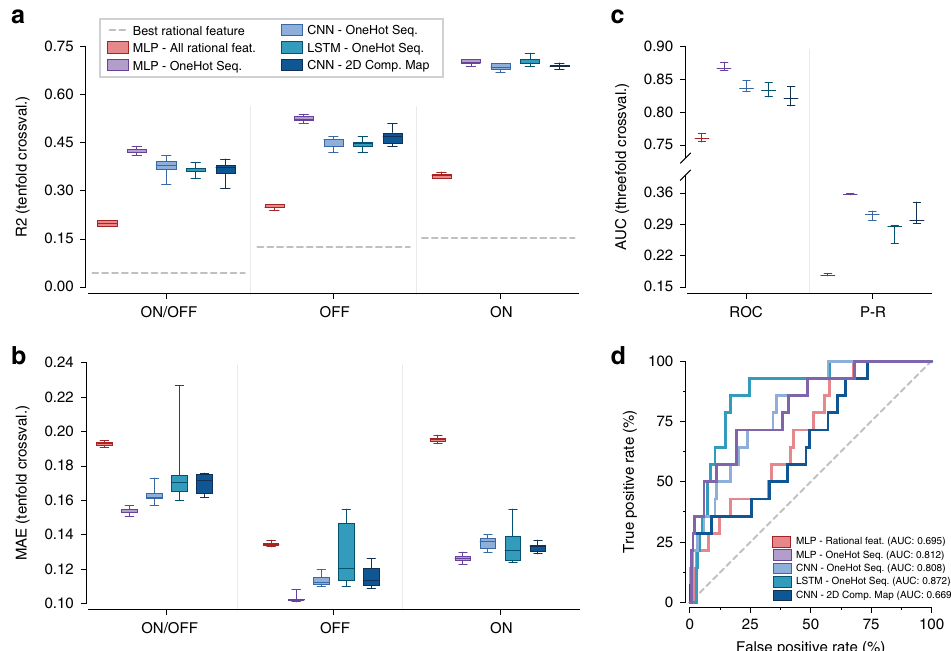
Fig. 4 Evaluation of neural network architectures with increased capacity. Performance metrics for convolutional neural networks (CNN) and long short- term memory (LSTM) networks trained on one-hot encoded toehold sequences, as well as a CNN trained on a two-dimensional, one-hot encoded sequence complementarity map. All models are compared to the previously reported MLPs trained on the 30 pre-calculated thermodynamic features and one-hot toehold sequences. For regression-based predictions, a shows box-and-whisker plots for R 2 metric, while b shows box-and-whisker plots for mean absolute error (MAE) for all models. In the case of classi fi cation-based predictions, c shows box-and-whisker plots of the area under the curve (AUC) of the receiver – operator curve (ROC) and the precision-recall curve (P – R) for all tested models. In both regression and classi fi cation, the one-hot encoded sequence MLP delivered a top-in-class performance as compared to higher-capacity deep-learning models. d ROC curves of pre-trained higher-capacity classi fi cation models validated with an unseen 168-sequence external dataset from Green et al. 2 . For all box-and-whisker plots, the horizontal line indicates the median, box edges are at the 25th and 75th percentiles, and whiskers indicate the smaller of either 1.5 × IQR or max/min. All source data are provided as a Source Data fi